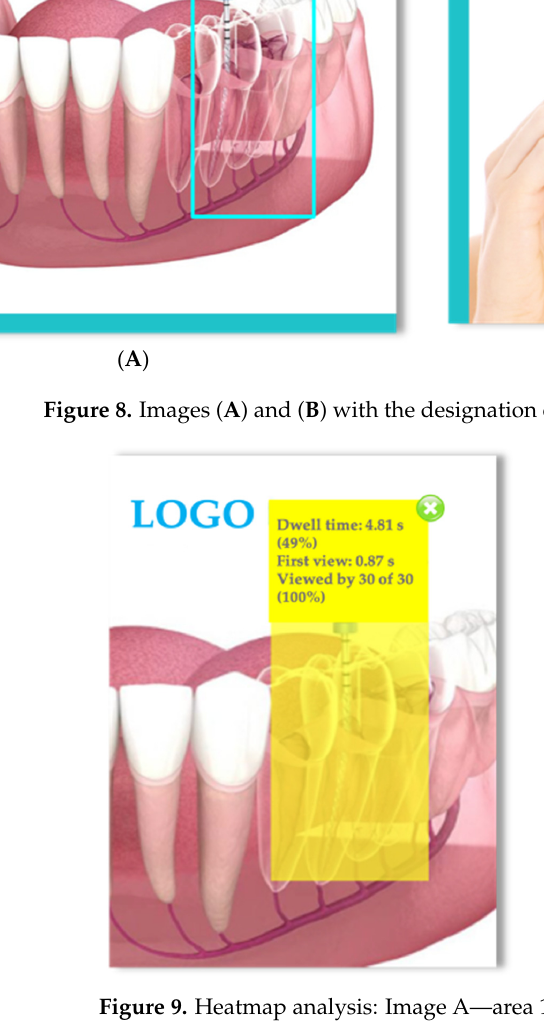
Figure 9. Heatmap analysis: Image A—area 1.